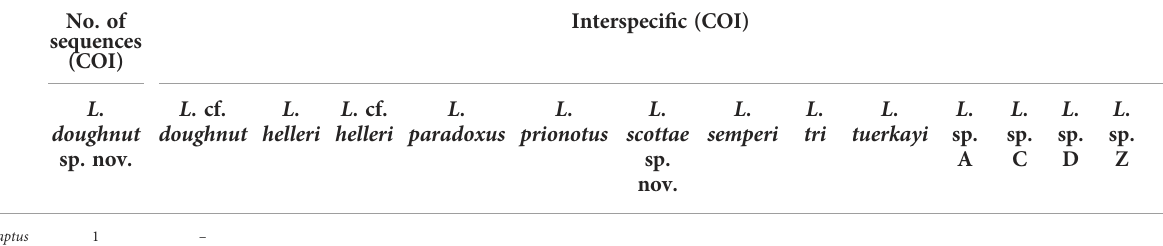
Lithoscaptus doughnut sp. Lithoscaptus cf. doughnut Lithoscaptus helleri Lithoscaptus cf. helleri Lithoscaptus paradoxus Lithoscaptus prionotus Lithoscaptus scottae sp. nov. Lithoscaptus semperi Lithoscaptus tri Lithoscaptus tuerkayi Lithoscaptus sp. A Lithoscaptus sp. C Lithoscaptus sp. D Lithoscaptus sp.